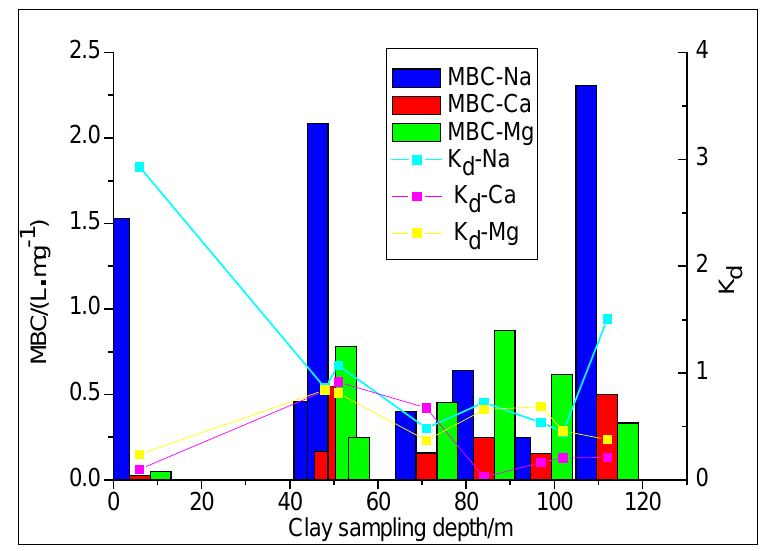
Figure 4. The maximum buffering capacity (MBC) trend and the linear distribution coefficient of clay for Na + , Ca 2+ and Mg 2+ in groundwater. Note: K d is the partition coefficient in the Henry equation (L kg −1 ).